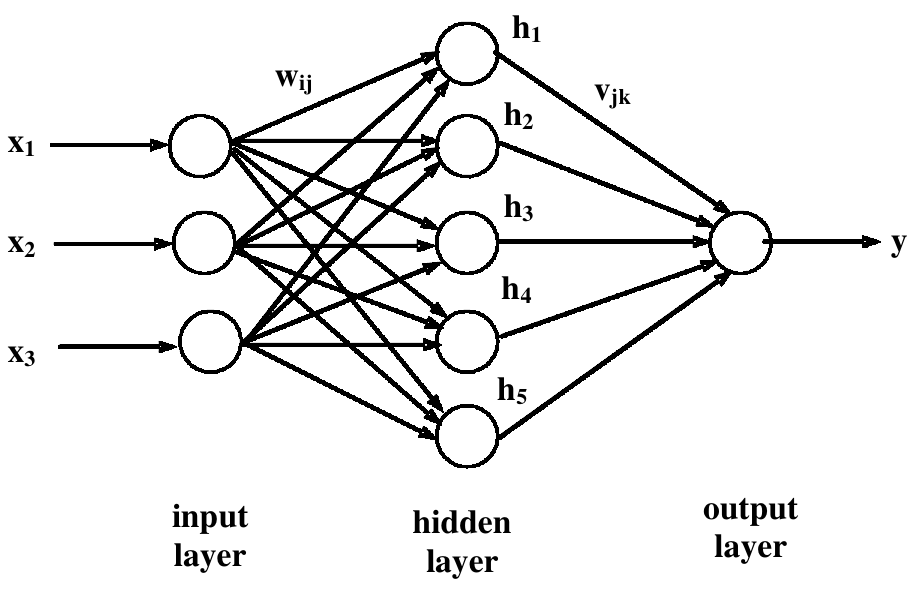
Fig. 2 A multi-layer feedforward neural